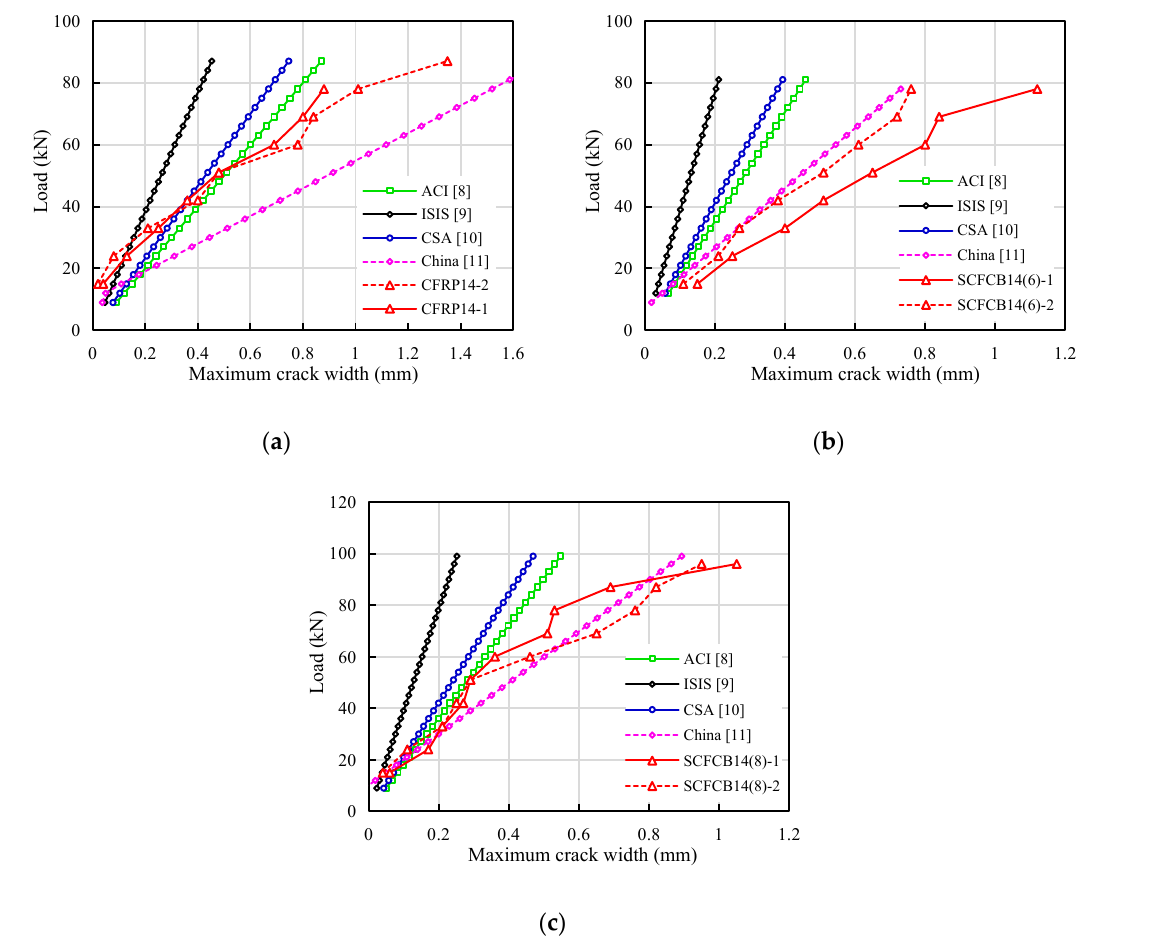
Figure 7. Comparison of experimental and standard calculation curves: ( a ) CFRP14 crack width calculation curve; ( b ) SCFCB14 (6) crack width calculation curve; ( c ); SCFCB14 (8) crack width calculation